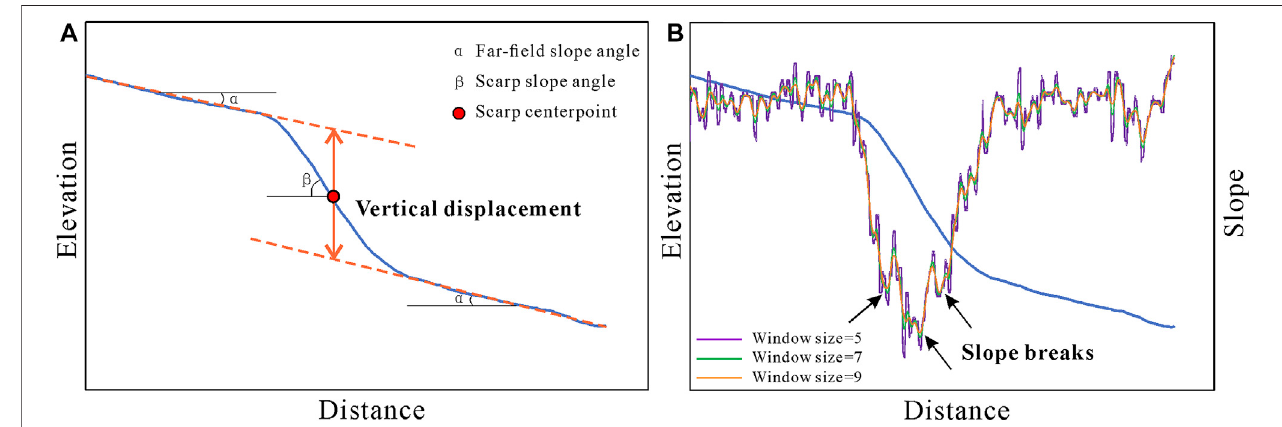
FIGURE 4 | (A) Measurement of vertical displacement from the extracted topographic pro fi le. (B) Identi fi cation of slope breaks in the gradient pro fi le which is calculated with a sliding window of different size.